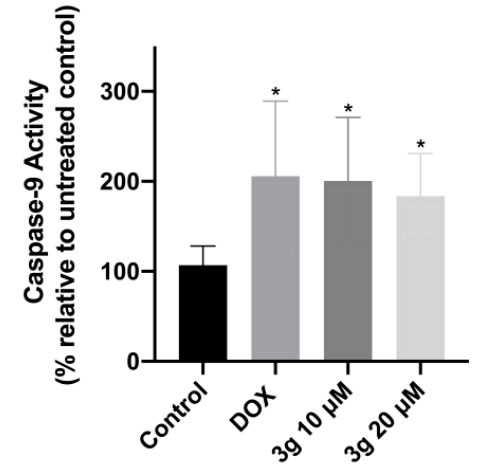
Figure 5. T47D caspase-9 activity results. Cells were treated for 48 h with doxorubicin (DOX) at 10 µM, as the positive control, and 3g at 10 and 20 µM, and the results are relative to untreated cells (control). The activity of caspase-9 was evaluated using a Caspase-Glo kit from Promega, as described in Material and Methods. Data are expressed as mean ± SD (2 independent assays, n=4 in each). * p < 0.05 compared to control.